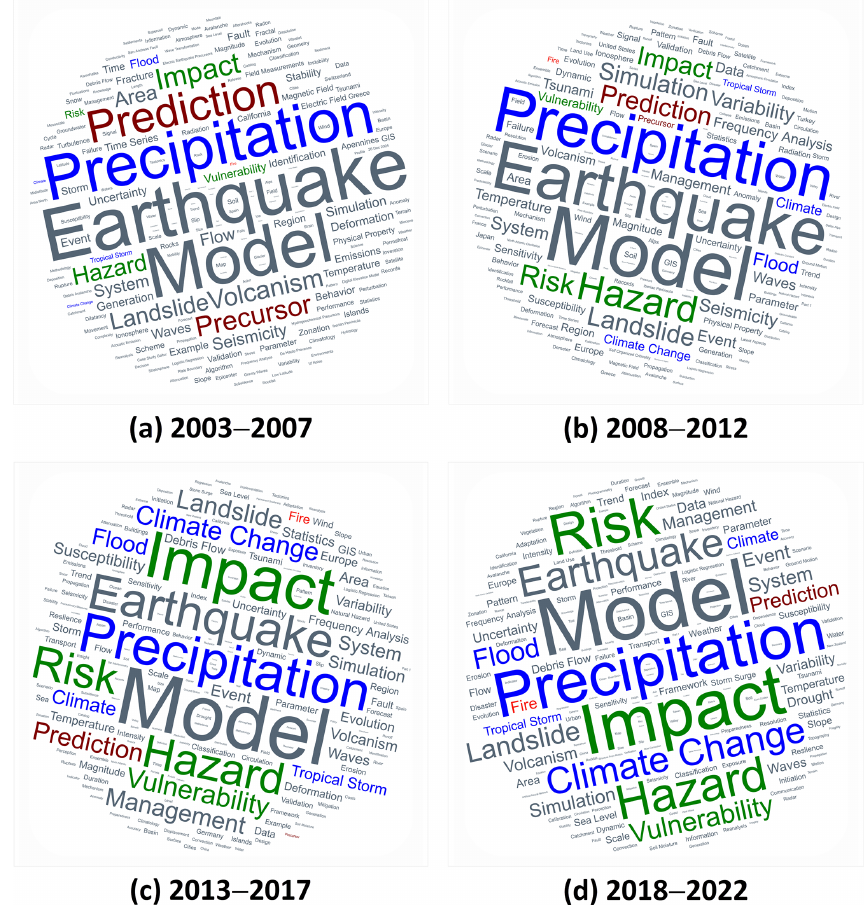
Figure 5. Word clouds of NHESS article keyword phrases for four 5-year periods: (a) 2003–2007 (597 unique keyword phrases, 292 articles with keywords), (b) 2008–2012 (1682 unique keywords, 1018 articles), (c) 2013–2017 (1970 unique keywords, 989 articles), (d) 2018– 2022 (1757 unique keywords, 811 articles). Keywords as given by Clarivate’s (2022) Web of Science “KeyWords Plus”, a reflection